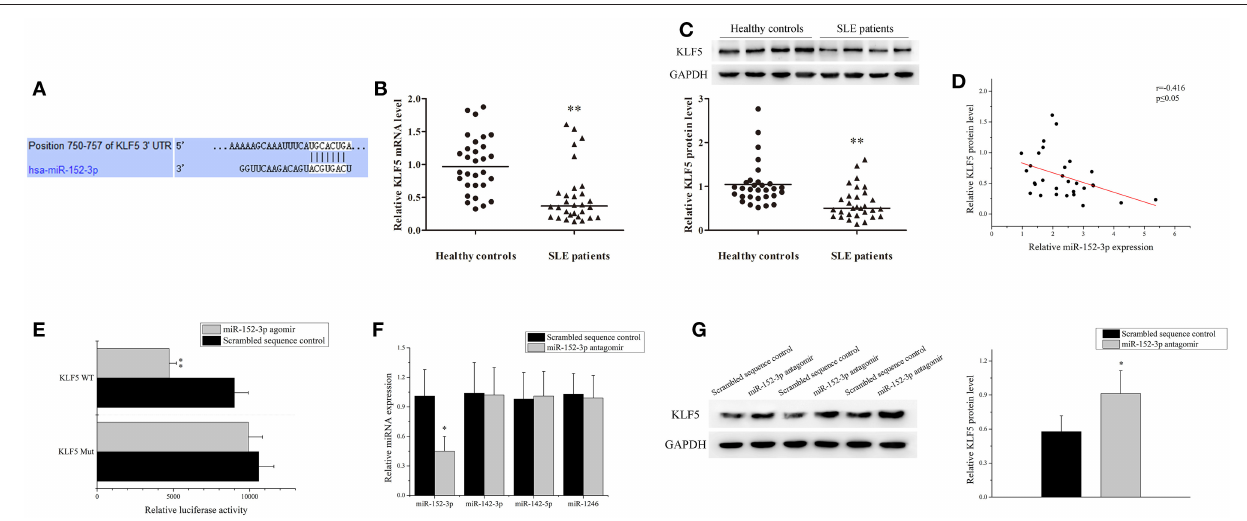
FIGURE 3 | Identification of miR-152-3p-targeting mRNAs in SLE B-cells. (A) The sequence of miR-152-3p-binding site in 3 ′ -untranslated region (3 ′ -UTR) of KLF5. (B) The KLF5 expression level in B-cells isolated from healthy controls or patients with SLE ( n = 30 for each group) was analyzed by real-time PCR and normalized to GAPDH. The variables were compared using the Mann-Whitney U -test. (C) The KLF5 protein expression in B-cells isolated from healthy controls or patients with SLE ( n = 30 for each group) was analyzed using western blot analysis. One representative blot is shown (upper panel). The intensity of bands was semi-quantitated and normalized to GAPDH (lower panel). The variables were compared using the Mann-Whitney U -test. (D) The correlation between miR-152-3p expression and KLF5 protein level in SLE B-cells ( n = 30). (E) Relative firefly luciferase activity in Jurkat cells co-transfected with miR-152-3p agomir or scrambled sequence control together with luciferase reporter constructs containing either a WT or a mutated (Mut) KLF5 3 ′ -UTR. Data represents the mean of three independent experiments. (F) The miR-152-3p, miR-142-3p, miR-142-5p, and miR-1246 expression levels in SLE B-cells after transfection with miR-152-3p antagomir or scrambled sequence control were analyzed by real-time PCR. All experiments were performed in triplicate. The variables were compared using the paired t -test. (G) The protein level of KLF5 in SLE B-cells after transfection with miR-152-3p antagomir or scrambled sequence control. All experiments were performed in triplicate. One representative blot is shown (left panel). The intensity of bands was semi-quantitated and normalized to GAPDH (right panel). Data represents the mean of three independent experiments. The variables were compared using the paired t -test. * P < 0.05 and ** P < 0.01.